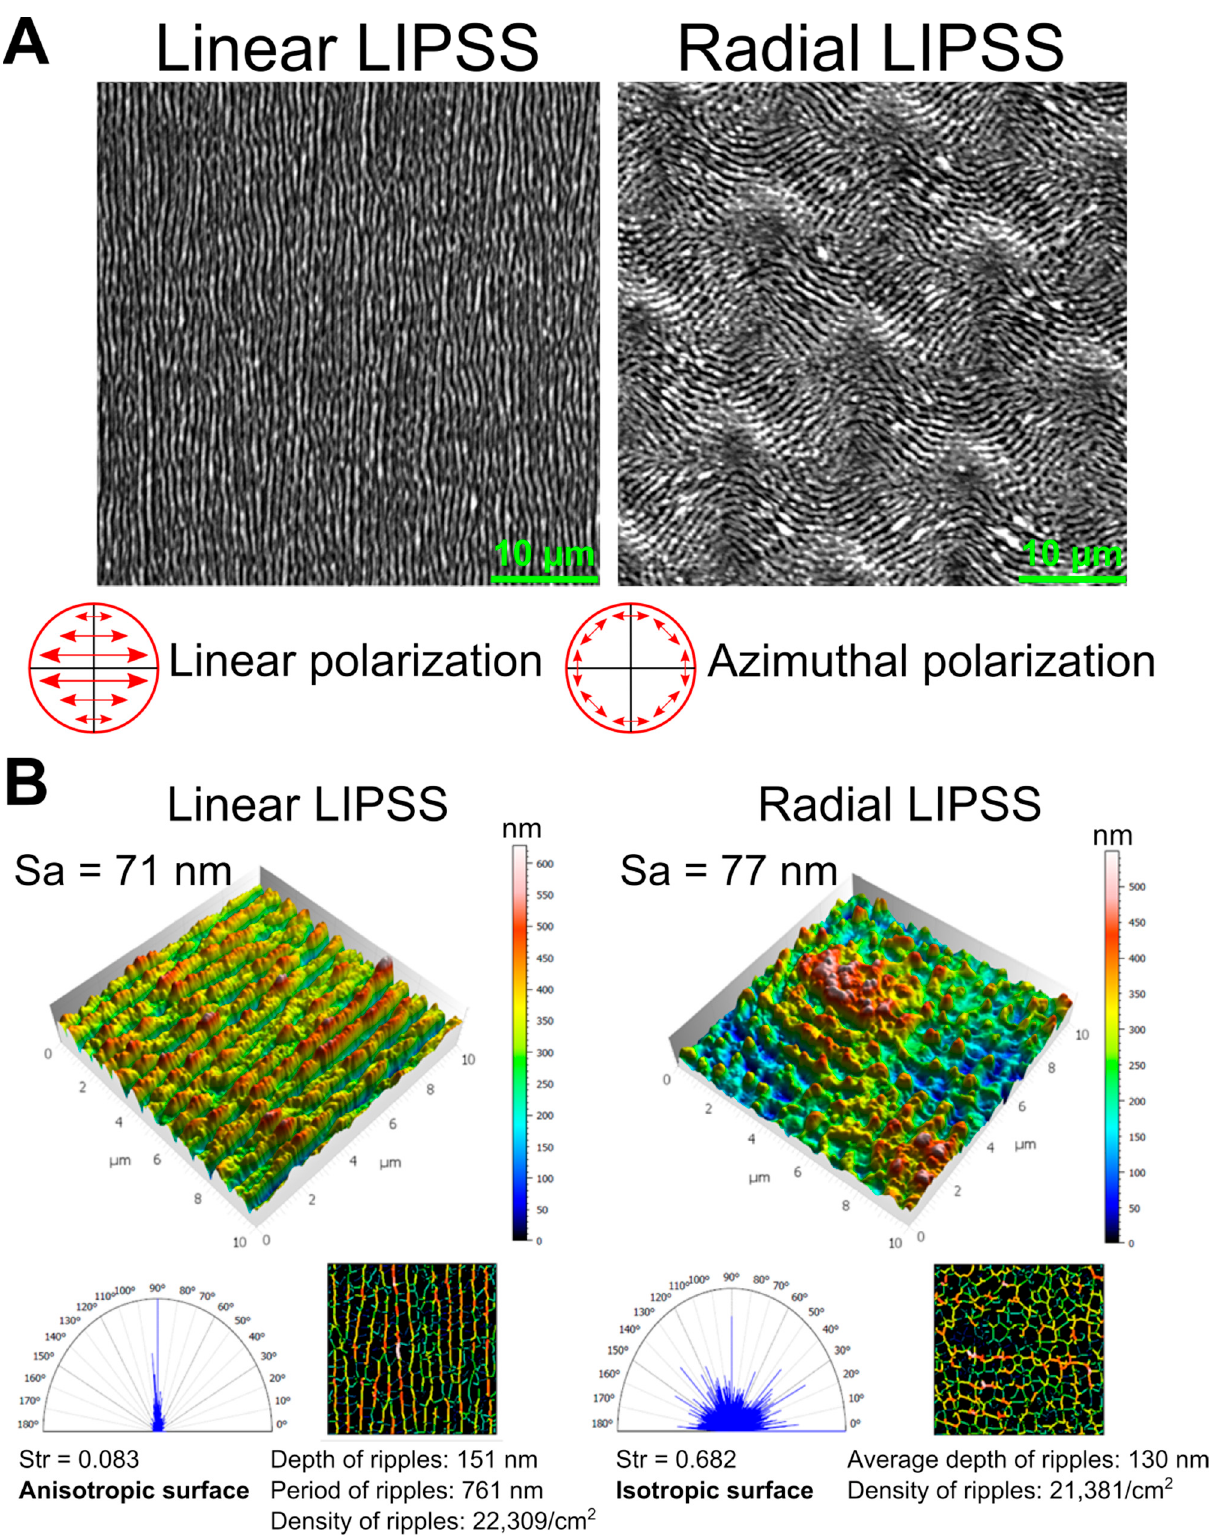
Figure 1. ( A ) SEM images of the two surface textures with linear or radial LIPSS (magnification 3000×). ( B ) 3D image reconstruction of the nanometer-scale surface texture with linear or radial LIPSS (data from atomic force microscopy images 10 μ m × 10 μ m) and surface analysis by Mountain Map ® software.